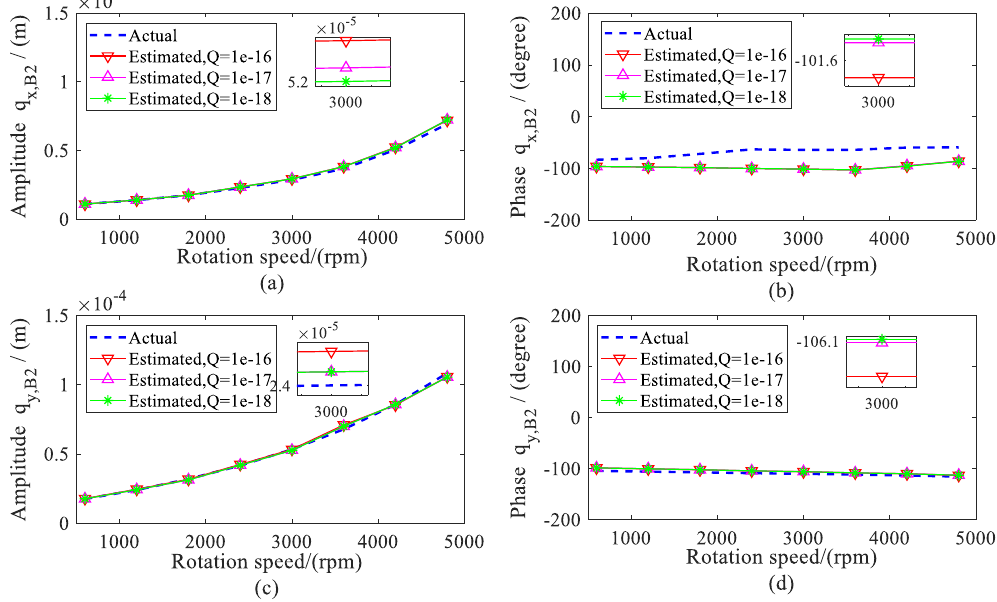
Figure 6. Actual and estimated displacements of bearing 2. ( a ) amplitude of q x, B 2 ; ( b ) phase of q x,B 2 ; ( c ) amplitude of q y, B 2 ; ( d ) phase of q y, B 2 .